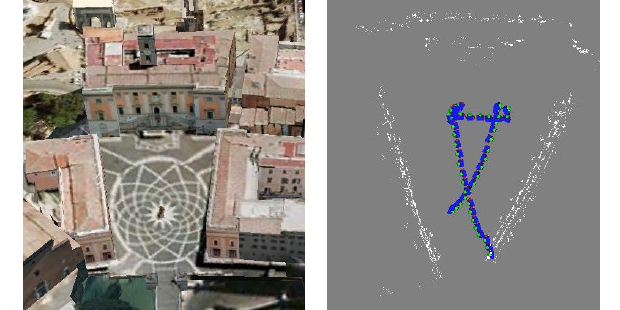
Figure 9 – Orientation of Campidoglio sequence: left: Aerial view of Piazza del Campidoglio (from Google Maps); right: camera stations and tie points Min Max Avg.